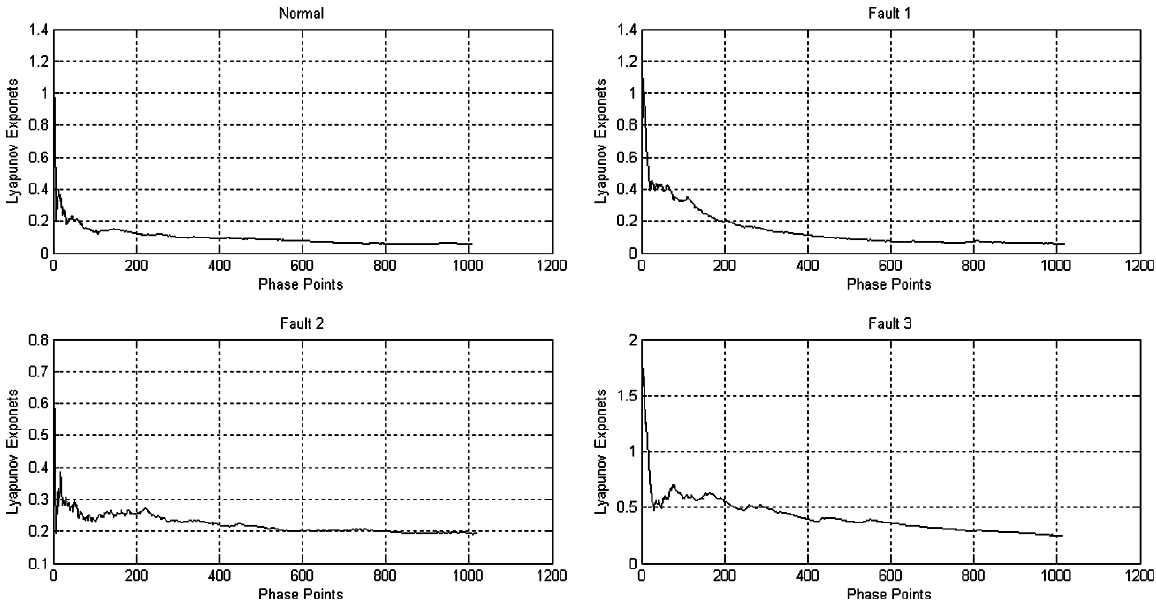
Fig. 7. Lyapunov exponents of vibration signals under different health